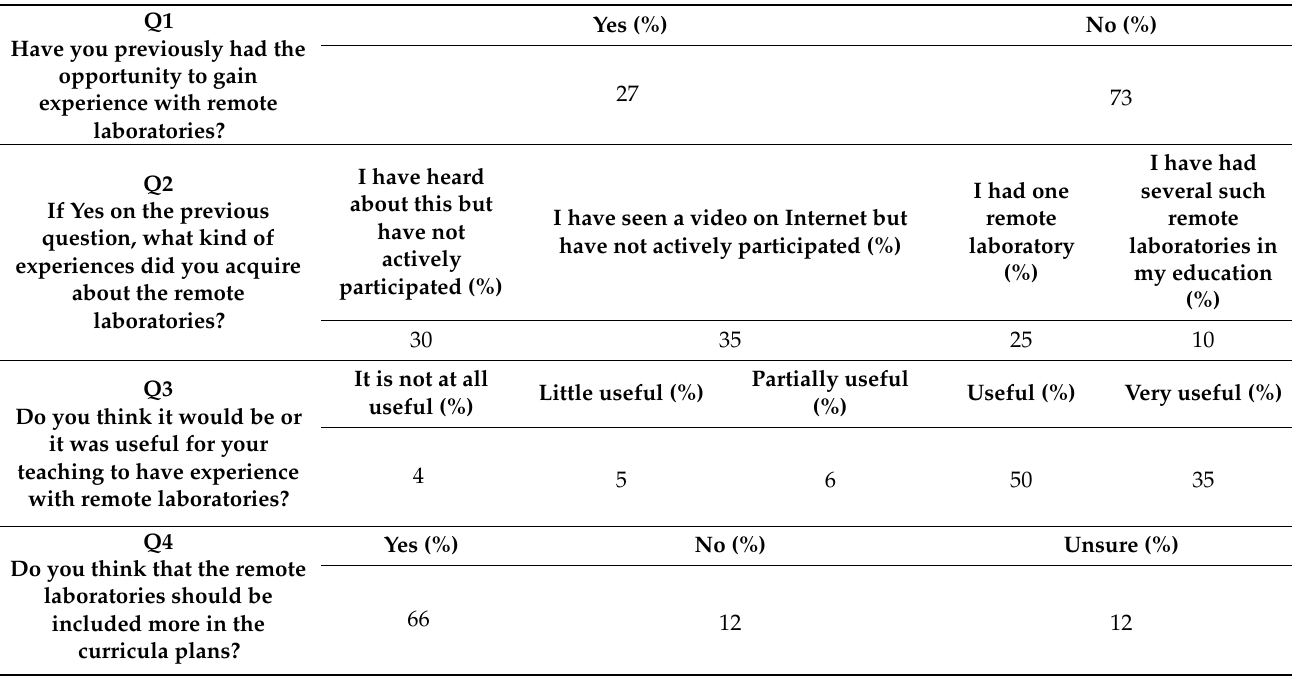
Table 5. Professors’ responses to expectation survey.